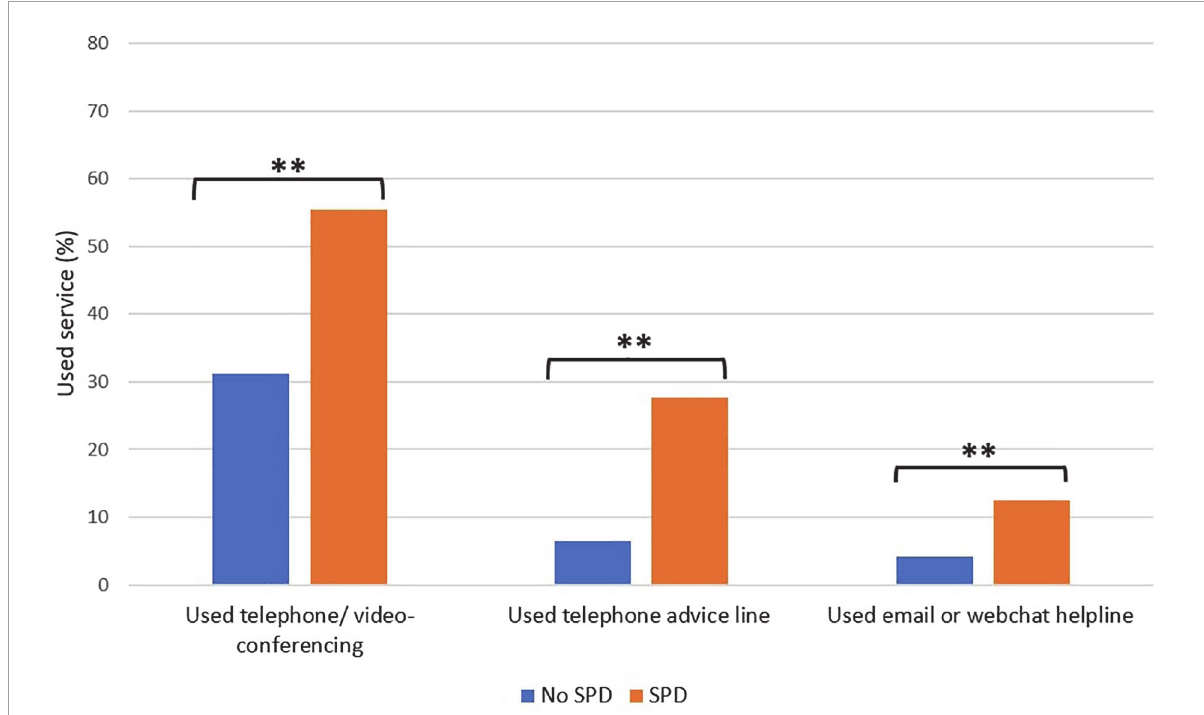
FIGURE2 Digital health service use by mental health status in 2021. ∗∗ P < 0.001, SPD = serious psychological distress.